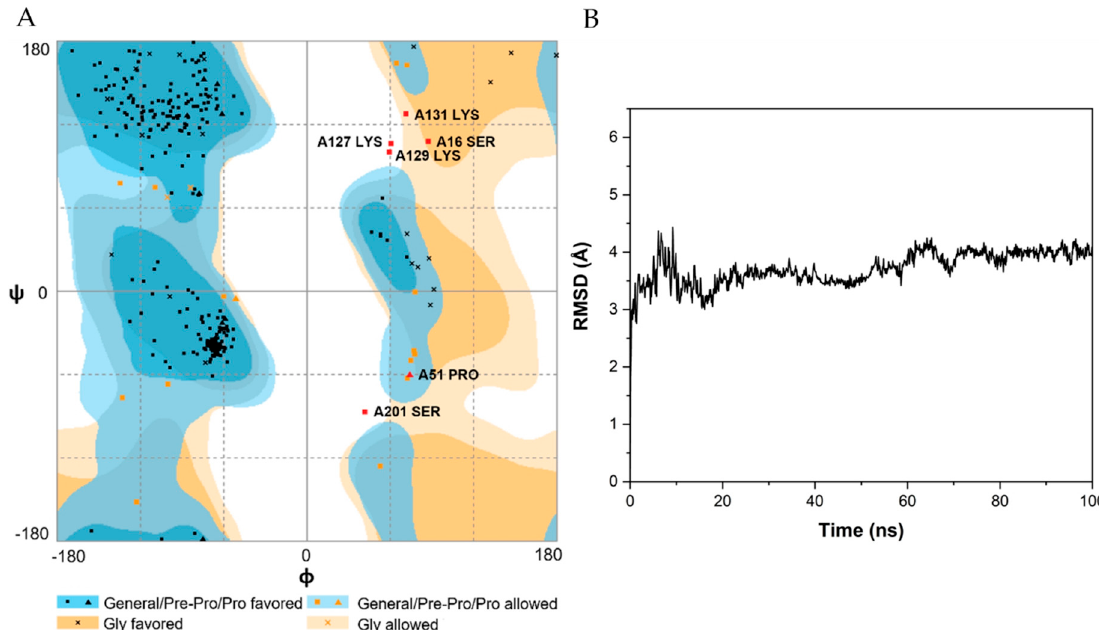
Figure 3. Validation of NitAF model. ( A ) Ramachandran plot of wild-type NitAF. The plot calculation on 3D model of wild-type NitAF was performed with RAMPAGE program. ( B ) MD simulation on wild-type NitAF structure. The RMSD value of the backbone atoms (C α , N, C) of the wild-type NitAF structure was calculated against the time simulation between 0 and 100 ns.